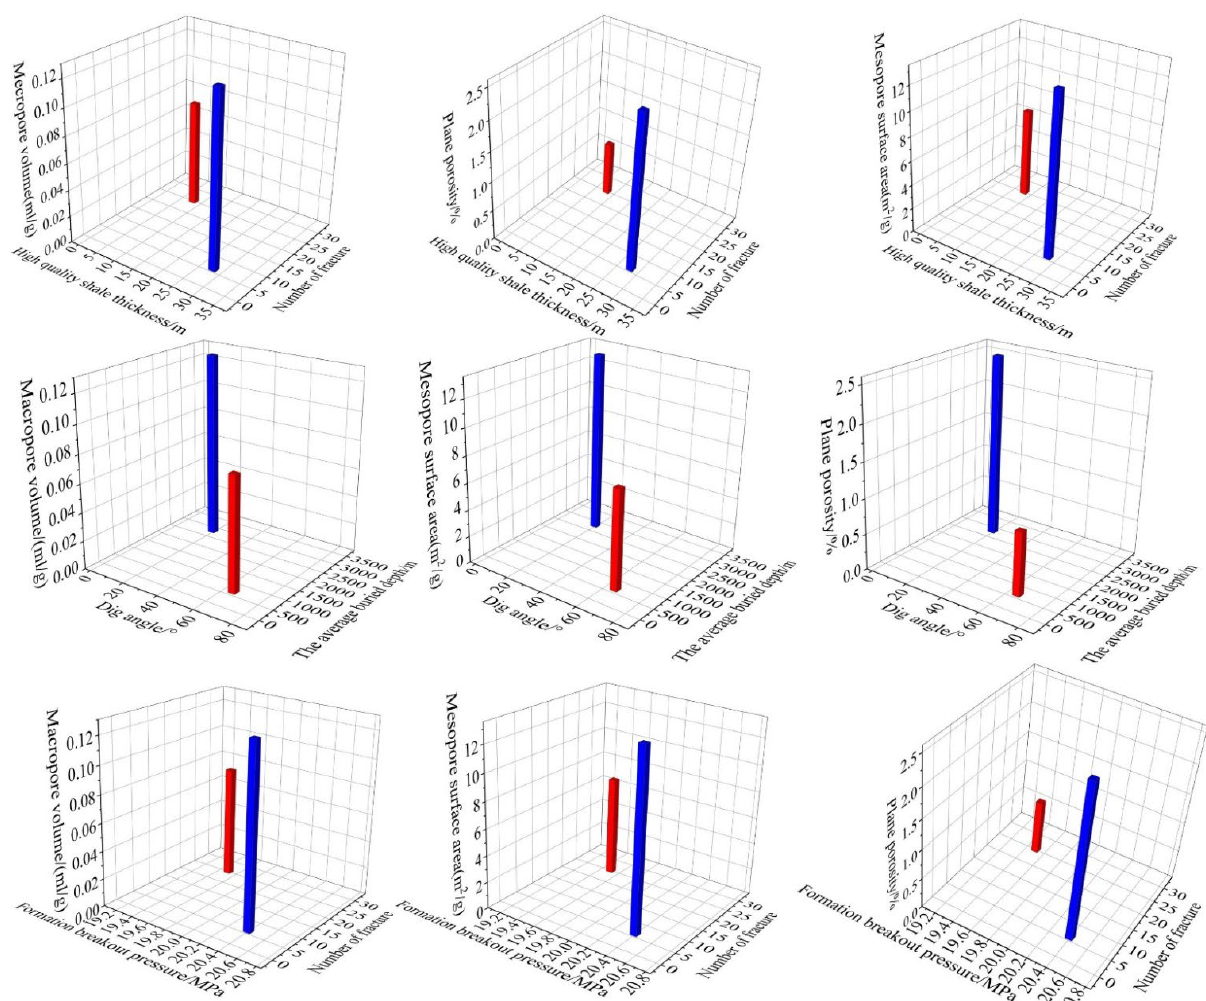
Figure 13. Relationship between tectonic preservation parameters and pore structure of the Wufeng- Longmaxi Formation and the Niutitang Formation in northern Guizhou Province (The blue bars represent the Wufeng-Longmaxi Formation, and the red bar represent the Niutitang Formation).